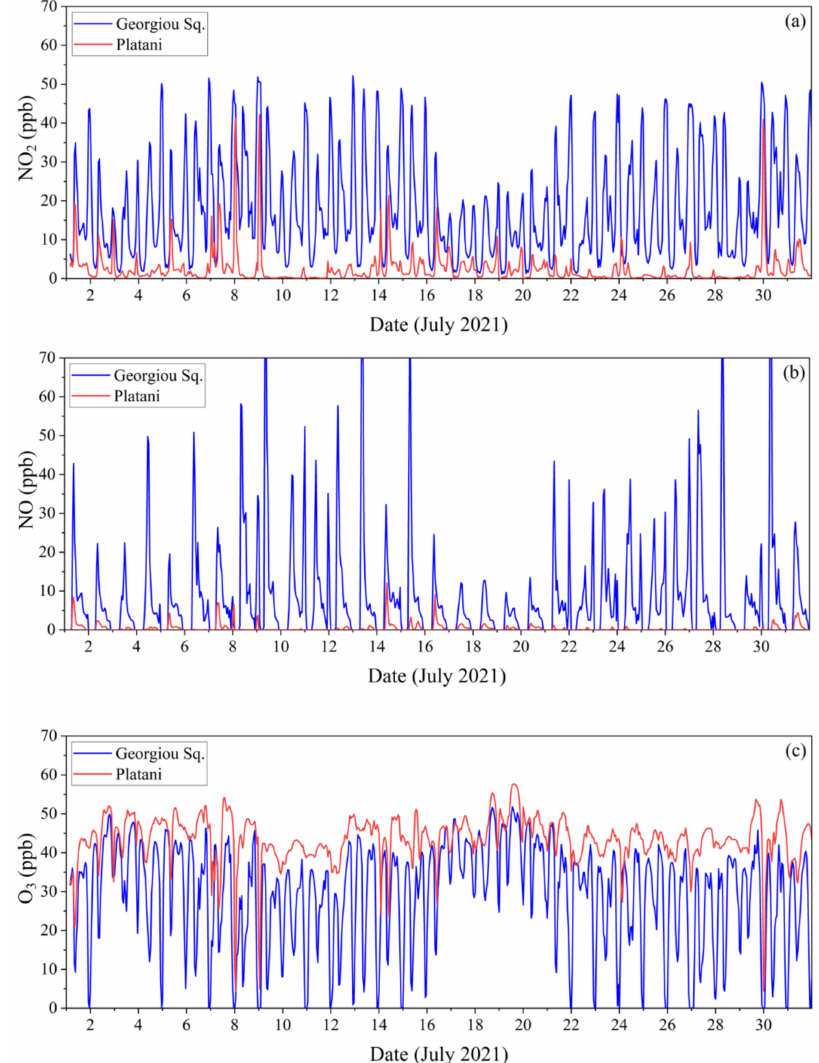
Figure 12. Predicted time series of ( a ) NO 2 , ( b ) NO and ( c ) O 3 in Georgiou Square (city center) and Platani (outer suburbs) during July